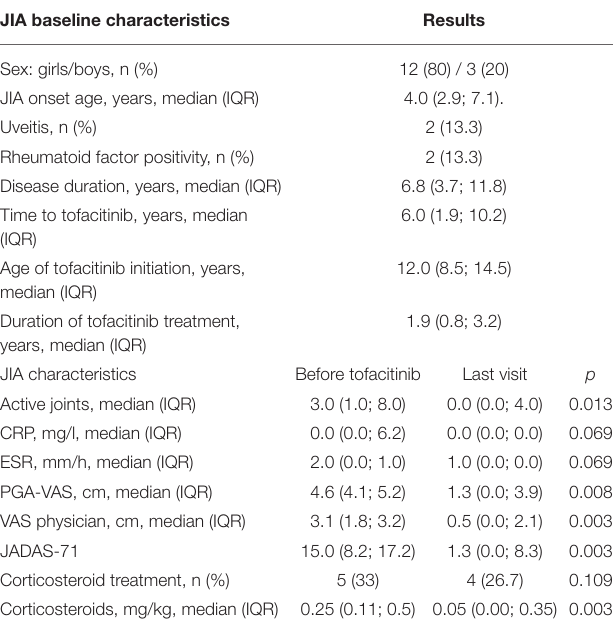
TABLE 1 | JIA patients: baseline characteristics and clinical course. JIA baseline